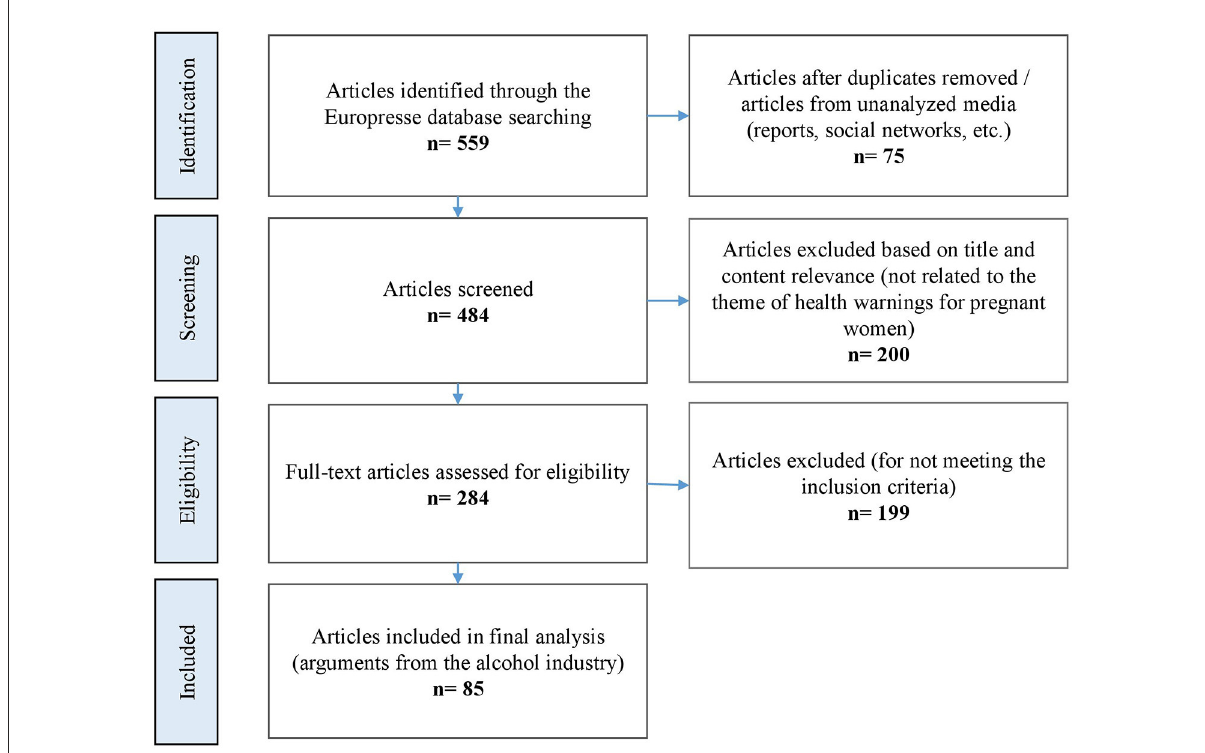
FIGURE1 Flow chart of the inclusion process for press articles identified by searching the Europresse